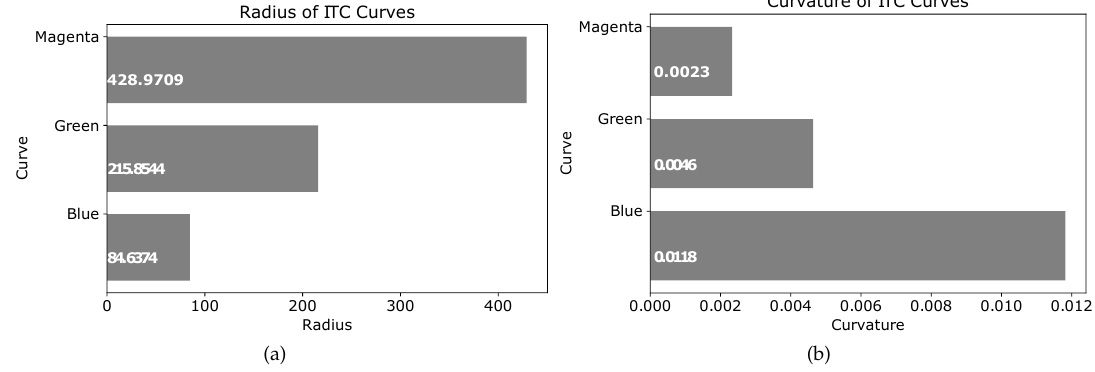
Figure 22. Radius and curvature of blue ( ψ 2 = 50), green ( ψ 2 = 75), and magenta ( ψ 2 = 100) curves in Figure 21. ( a ) Radius of curves at different points. ( b ) Curvature of curves at different